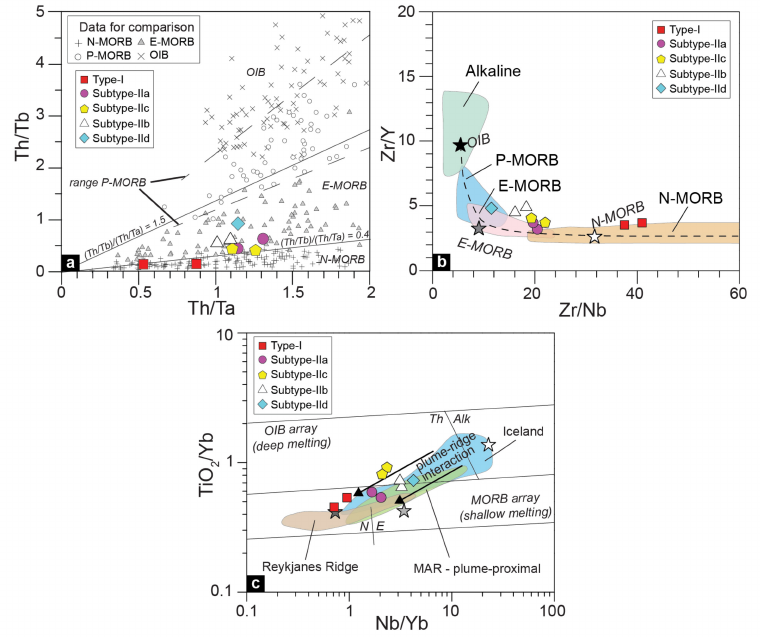
Figure 14. Diagrams showing the co-variation of some trace element ratios for subvolcanic and volcanic rocks from the sheeted dyke complex and volcanic sequence of the Band-e-Zeyarat ophiolite. ( a ) Th / Tb vs. Th / Ta diagram for primitive basalts for each geochemical type and subtype. Compositions of oceanic subduction-unrelated rocks are shown for comparison [9,86–88]. ( b ) Zr / Nb vs. Zr / Y diagram for primitive basalts for each geochemical type and subtype. N-MORB, E-MORB, and OIB end-members are from Sun and McDonough [73]. Fields indicate compositional variation for di ff erent types of basalts from subduction-unrelated ophiolites and modern oceanic setting. Data source [85–93]. The dashed line represents the mixing curve calculated using OIB and N-MORB end-members (from Le Roex et al. [89]). ( c ) Nb / Yb vs. TiO 2 / Yb diagram from Pearce [10] for primitive basalts for each geochemical type. Compositional fields for basalts erupted in modern plume–ridge interaction are shown for comparison [10]. Composition of typical N-MORB (dark grey star), E-MORB (light grey star), and OIB (white star) are from Sun and McDonough